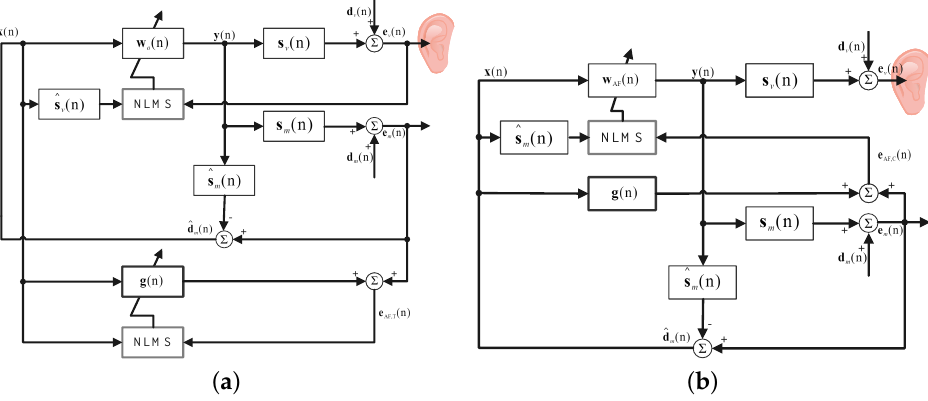
Figure 3. Block diagram of the auxiliary filter method (AFM). ( a ) Tuning stage. ( b ) Control